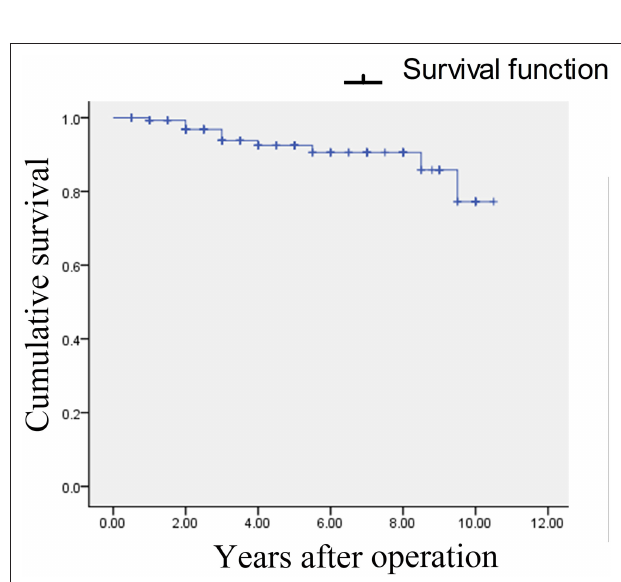
FIGURE 7 | Kaplan–Meier survival analysis. Pain recurred in 11